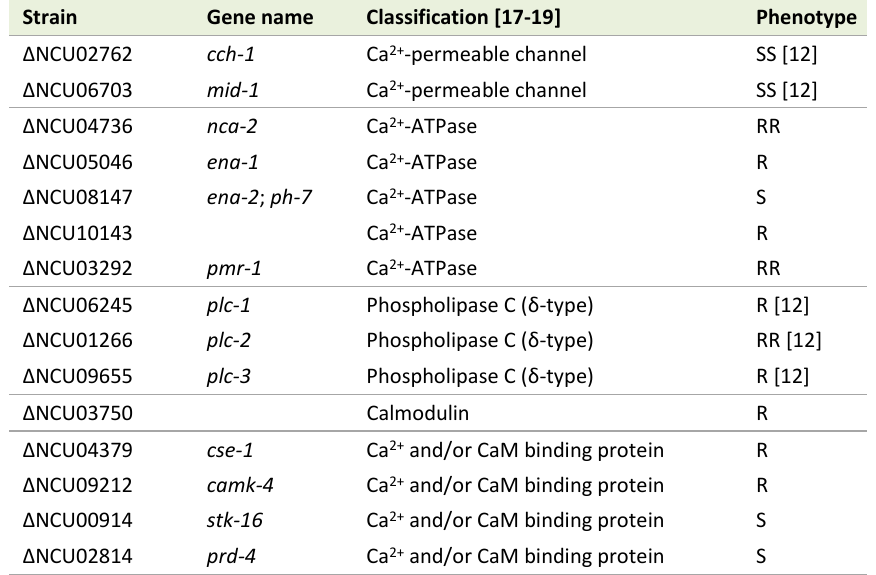
TABLE 1. Strains with Ca 2+ -related deleted genes that exhibit altered sensitivity to staurosporine when compared with wild type N. crassa .